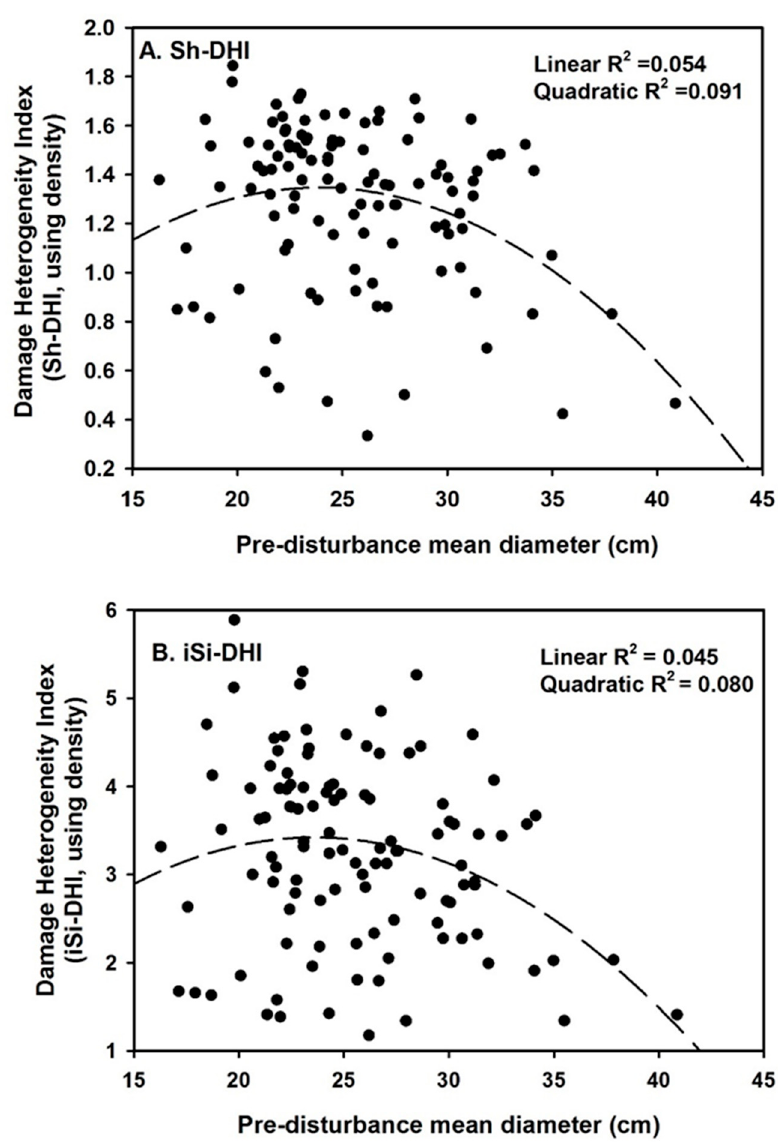
Figure 5. Damage heterogeneity index vs. pre-disturbance plot mean trunk diameter, for plots with 10-cm diameter minimum; n = 111. ( A ) DHI calculated with Shannon formula; ( B ) DHI calculated with inverse Simpson formula. Only significant regressions shown; quadratic regression shown if it had greater R 2 than linear regression.